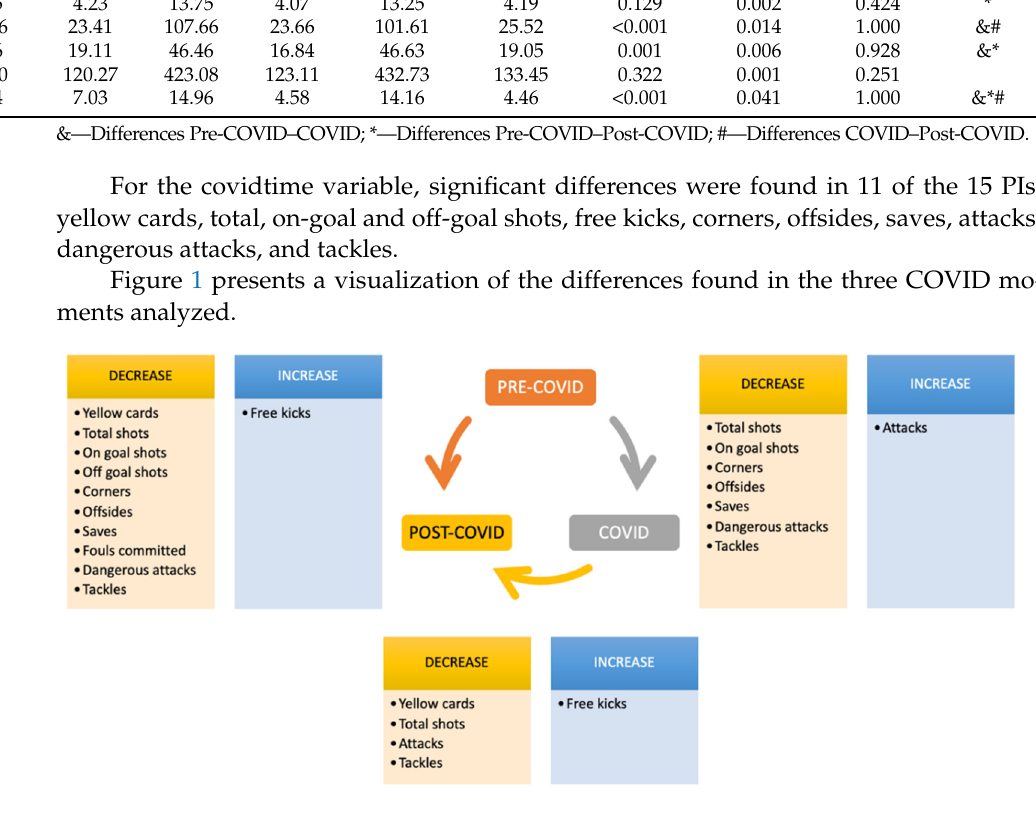
Table 3. Descriptive and inferential results of venue.